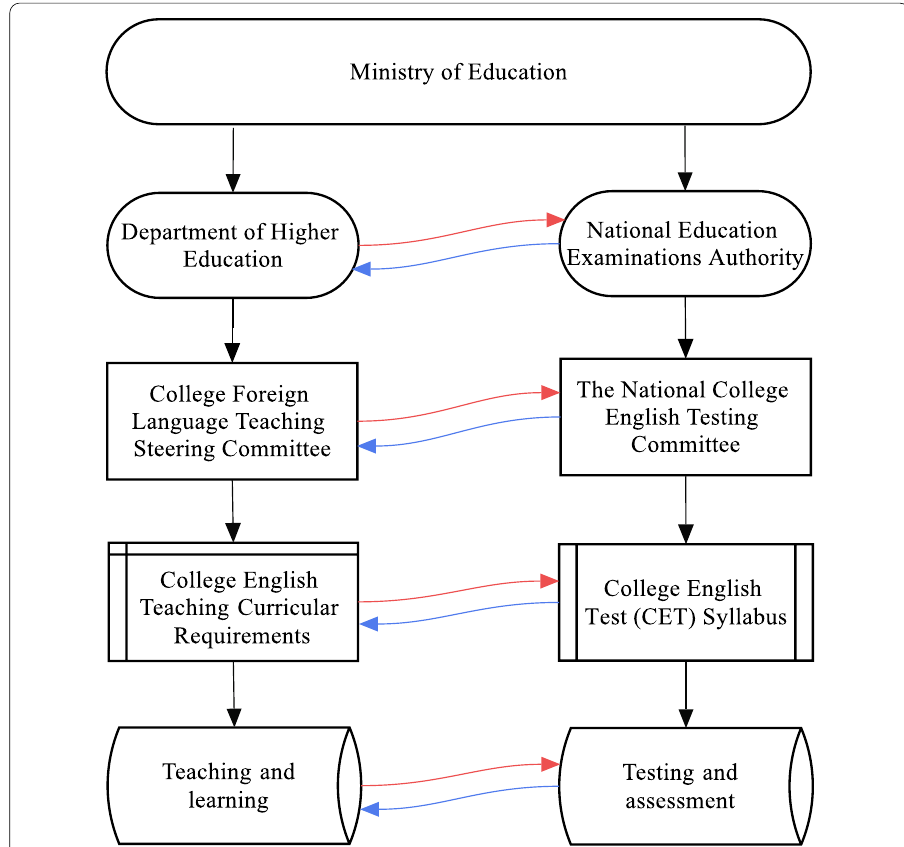
Fig. 1 An interconnected system of College English